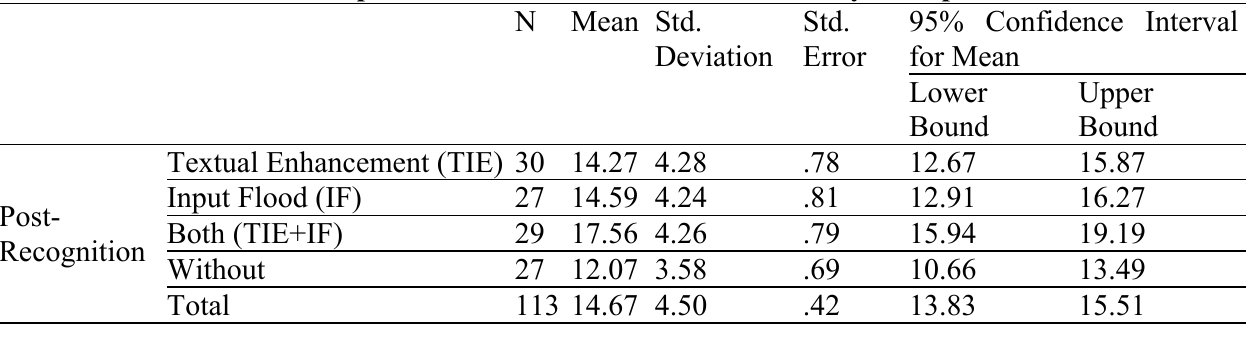
Descriptive Statistics Results of Production by Groups